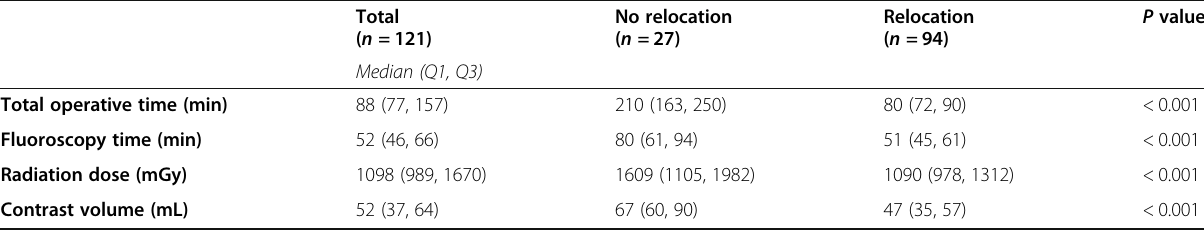
Table 2 Procedural metrics of 121 patients undergoing fenestrated endovascular aortic repair (FEVAR) using the Zenith Fenestrated AAA Endovascular® with large fenestrations for superior mesenteric artery incorporation